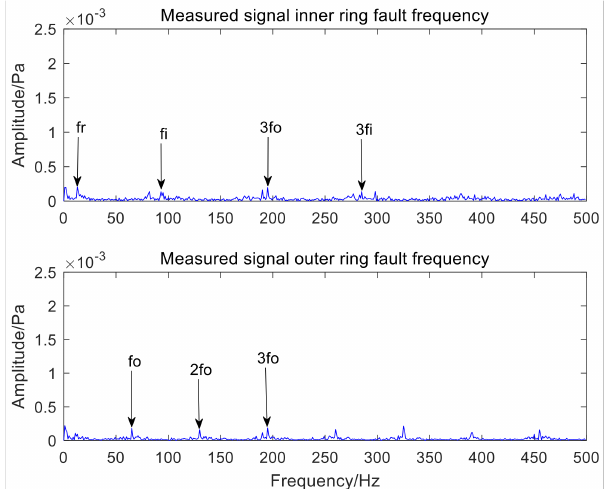
Figure 18. The envelope spectrum of an acoustic signal using the